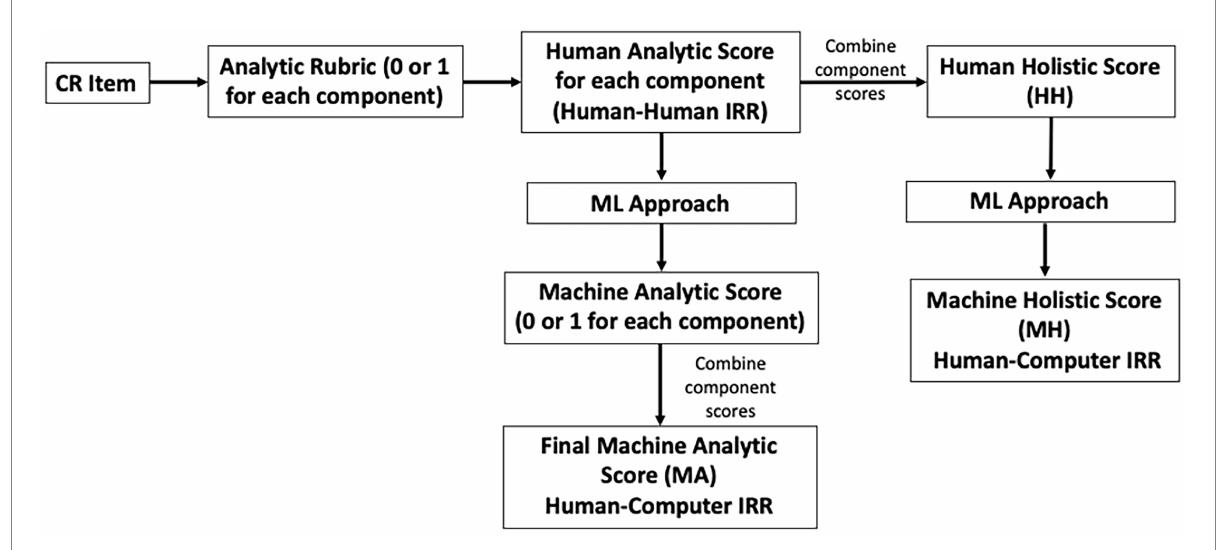
FIGURE 1 Scoring process for obtaining human holistic (HH), machine analytic (MA), and machine holistic (MH)